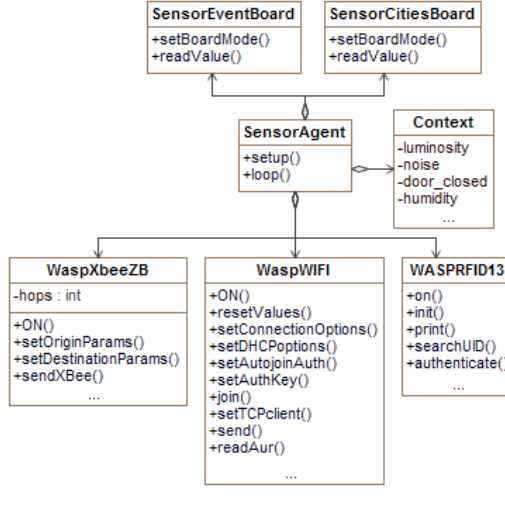
Figure 6. UML class diagram of SensorAgents running in Libelium waspmotes.